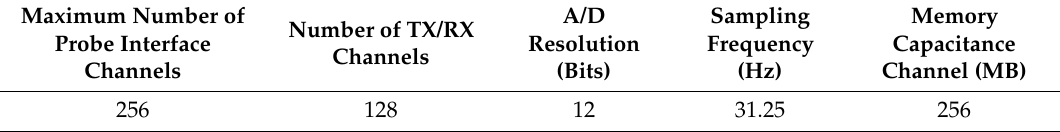
Figure 3. A simultaneous multimodality imaging system consisting of ultrasound (US) imaging equipment (RSYS0006MRF, Microsonic Co., Tokyo, Japan) and an MRI scanner (Echelon Vega, 1.5T, Hitachi Co., Tokyo, Japan). The probe that was placed in the MRI scanner was connected to the US imaging equipment via a connector that passed through the walls shielding the MRI room and the control room. Table 2. Specifications of US imaging equipment.